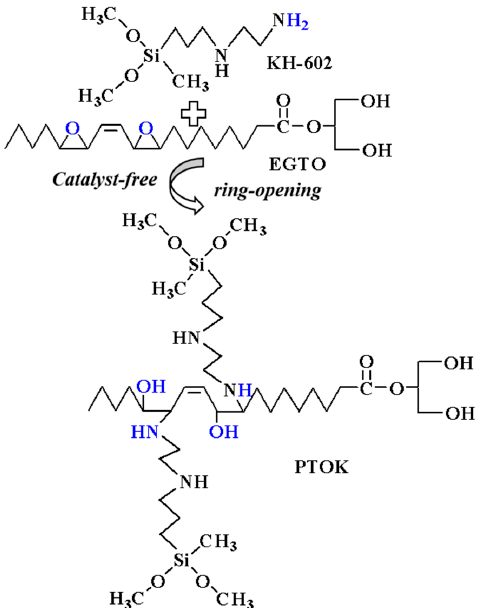
Figure 3. The synthesis route of tung oil-based polyol